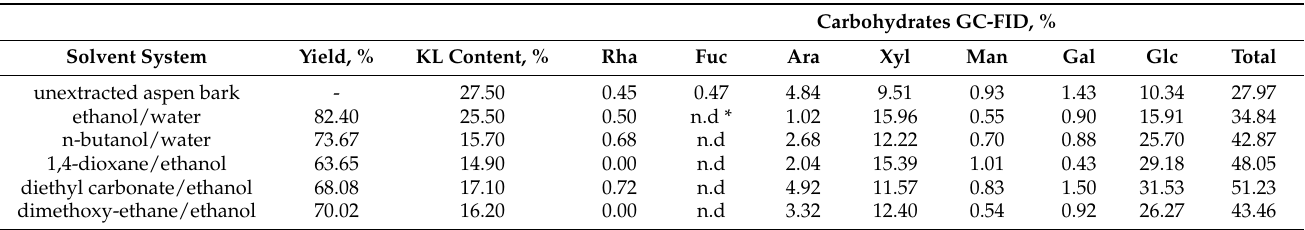
Table 7. The yield of cellulose-enriched residues and their composition in terms of Klason lignin content and completely hydrolyzed carbohydrate